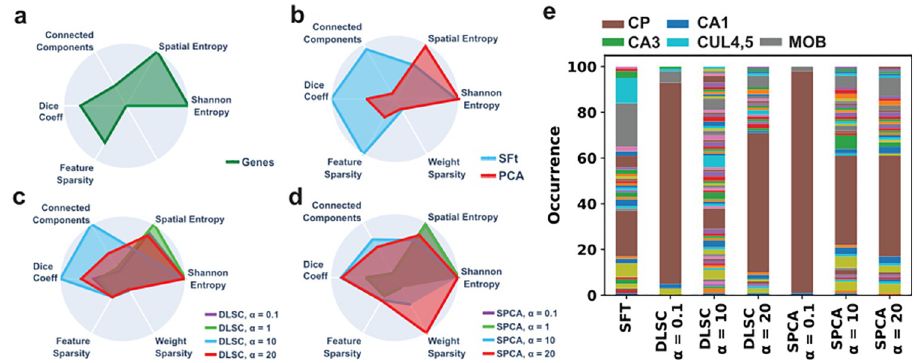
Fig 4. Relative performance metrics of DLSC, SPCA, and SFt. Representations derived from each method without additional clustering were evaluated along 5 metrics with increasing sparsity values ( α ) when possible. Metrics, minus weight sparsity, applied to individual genes (a) PCA had the poorest metrics, while SFt had the best Dice coefficients of any method, correlating with feature sparsity and connected component score (b) . With increasing α , DLSC representations lose spatial entropy and gain feature sparsity, with fewer connected components and improvements in individual fit to ground truth as measured by Dice coefficient (c) . For SPCA, higher α increases weight sparsity while Dice and connected components peak at α = 10 (d) . Labeling all representations by the anatomy they best represent showed some brain regions were redundantly represented by all methods, with the caudate putamen (CP) overrepresented across all methods and α values, with representation diversity peaking with Dice (e)